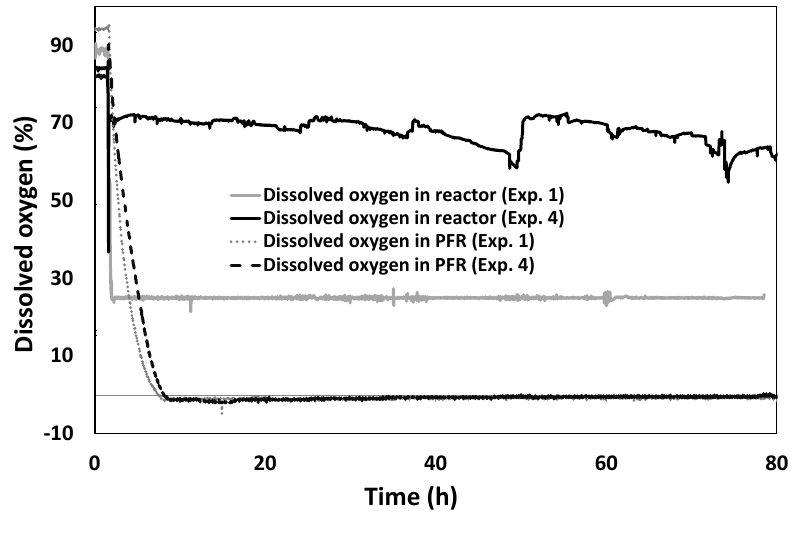
Figure 1. Dissolved oxygen in main reactor and in plug flow reactor in experiments 1 and 4 (Exp. 1 and Exp.